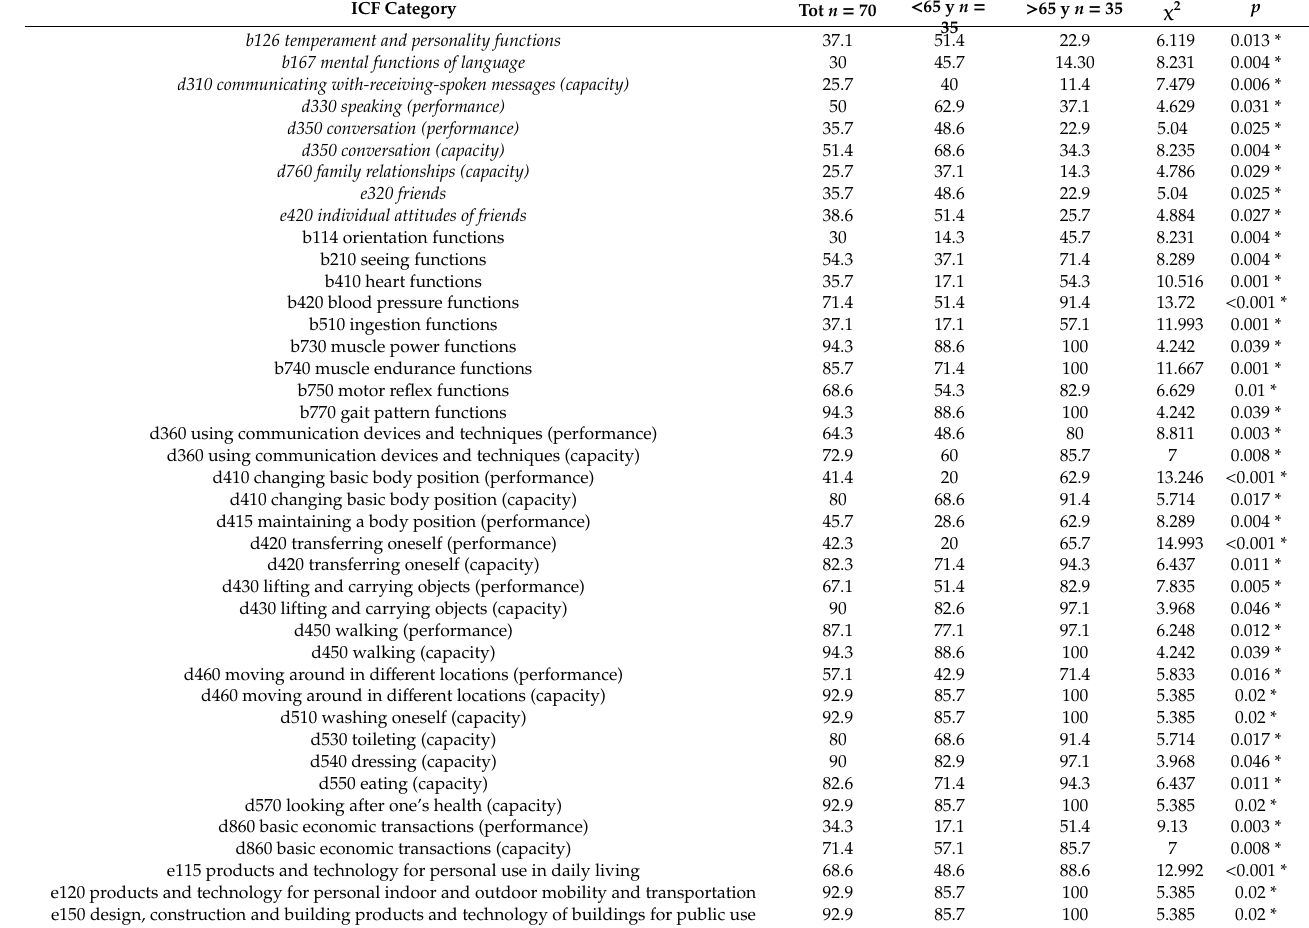
Table 3. ICF variables ( n = 41) in which older and younger patients’ groups demonstrated a significant di ff erence in the Chi-squared test ( χ 2 ). Percentages of participants presenting an alteration are